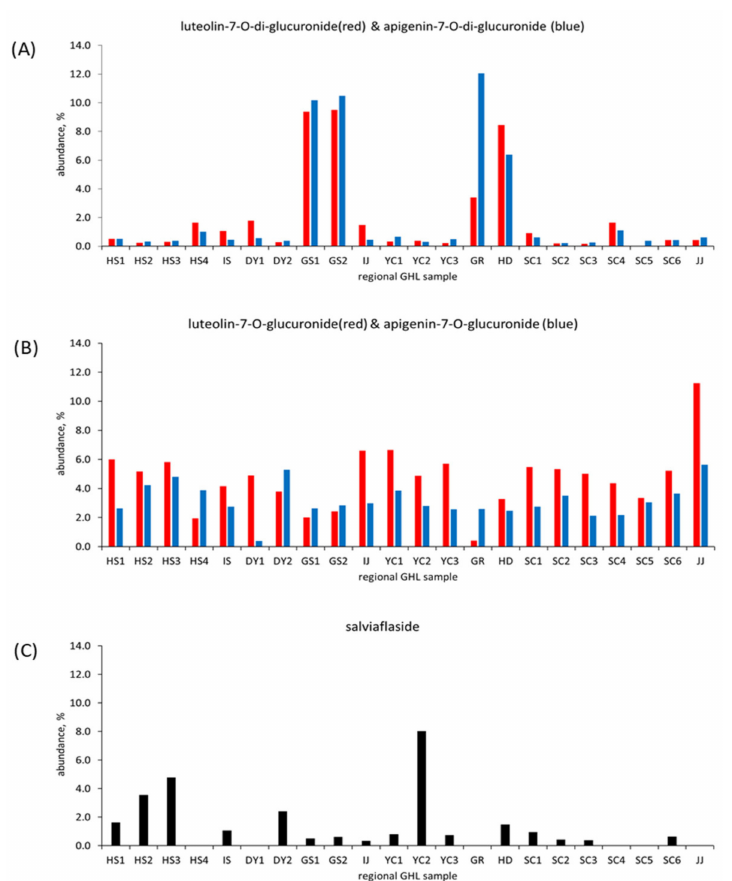
Figure 5. Comparison between the regional GHL extracts showing unique patterns in the compositional characteristics of ( A ) di-glucuronide conjugate, ( B ) mono-glucuronide